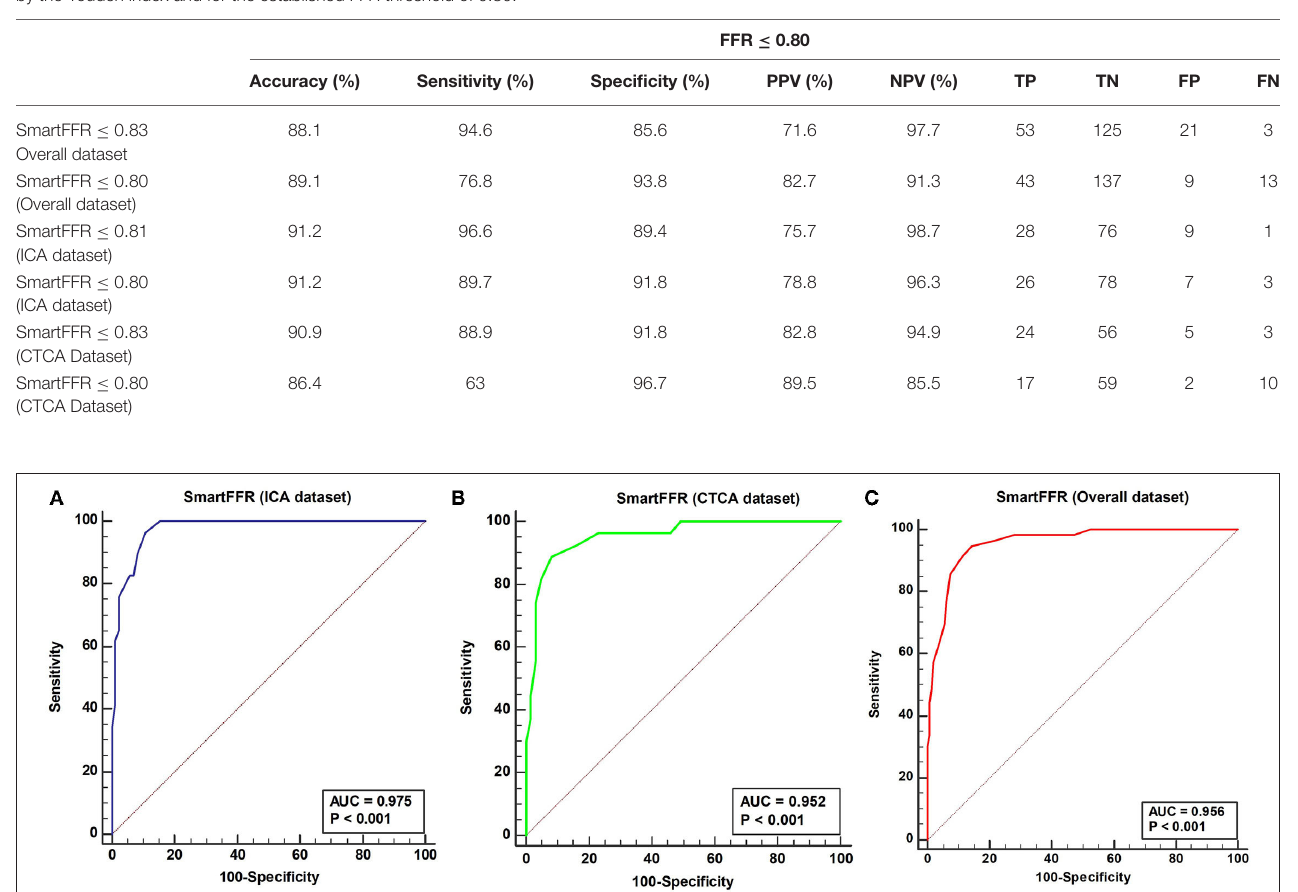
TABLE 1 | Diagnostic performance of SmartFFR for the overall dataset, the ICA-derived dataset and the CCTA-derived dataset, for the optimal thresholds as calculated by the Youden index and for the established FFR threshold of 0.80.